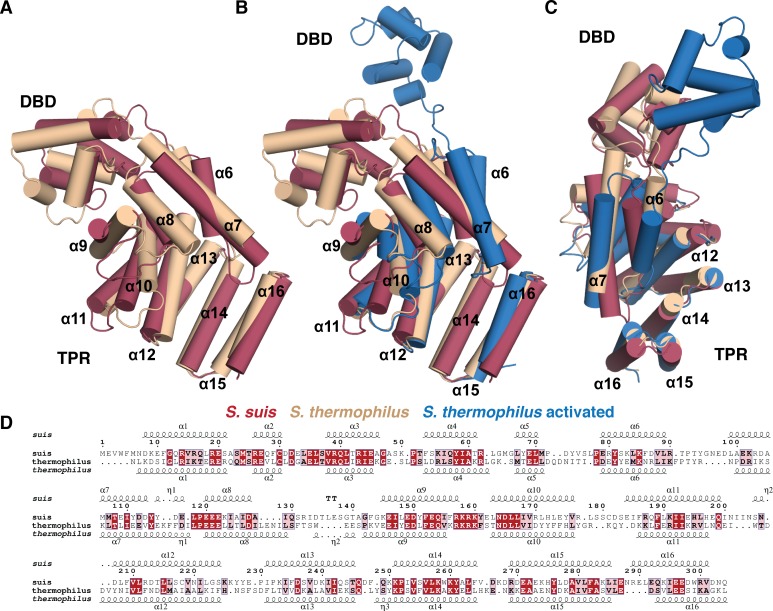
Structural comparison of ComR S. suis and ComR S. thermophilus.Alignment of ComR monomers using the TPR domain. (A) Alignment of the two apo-structures, (B) as (A) including the monomer from the ComR-ComS-DNA ternary complex. (C) Is panel (B) looking at the TPR from the activated DBD conformation (rotated y, -90° and x, 45° from the middle panel) (D) Sequence conservation and homology between ComR S. suis and S. thermophilus. Conserved residues are boxed in red with white lettering and homologous residues in pink with black lettering. The DNA binding domain (DBD) and TPR are labeled and helices labeled by number. The alignment was generated by PDBeFold and Espript3.